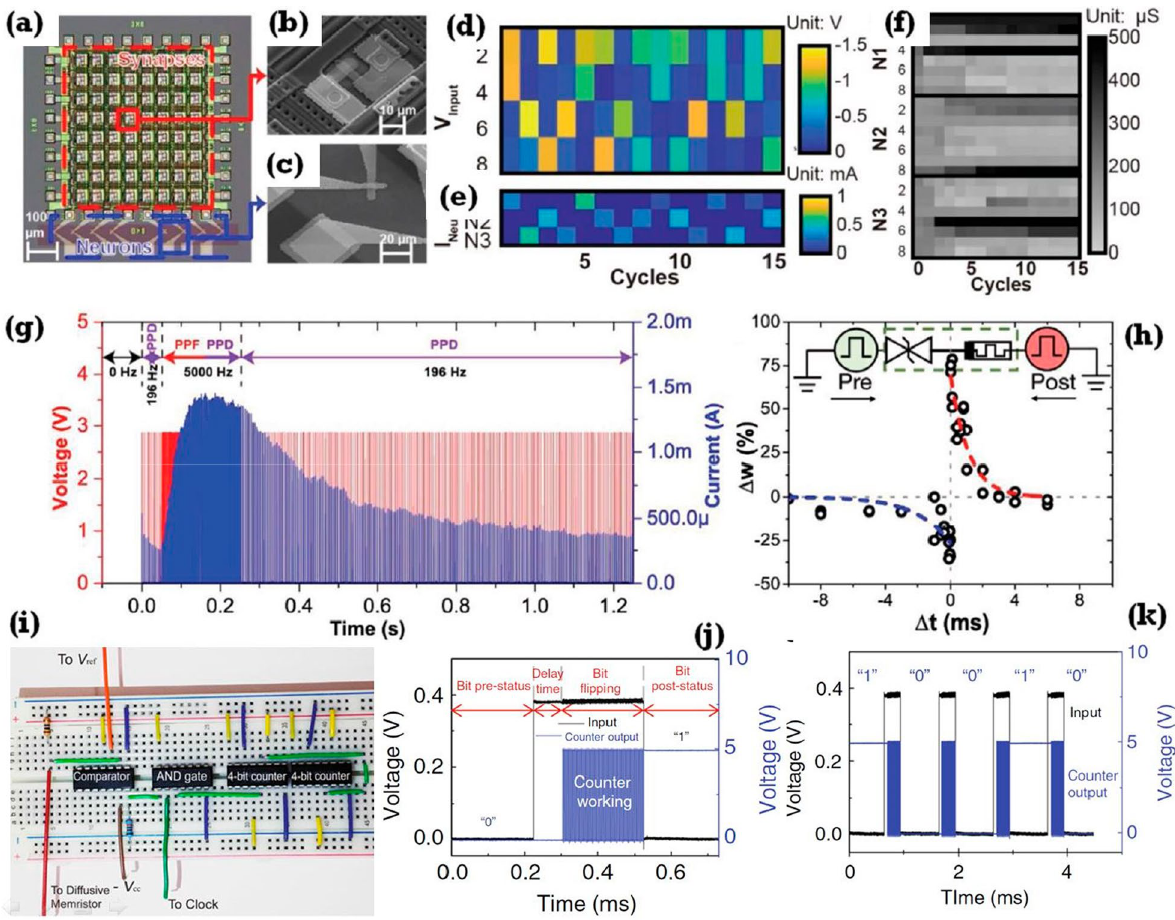
Fig. 29 a Optical image of 8 × 8 RRAM-based neural network in 1T1R configuration. Scanning electron microscope image of b 1T1R cell and c a single 1R cell. d The input pattern, e peak neural current and f synaptic weight at each training cycle. g Experimental observation of short-term synaptic plasticity. h Conductance (weight) change of the drift memristor synapse in series with a diffusive memristor, as a function of the interval between pre and postsynaptic spikes, showing biorealistic STDP. Reproduced with permission from [352]. Copyright 2019 John Wiley and Sons Publishing. i Circuit arrangement of a RRAM device for TRNG application on bread board. j One counter output in response to 1 kHz input voltage pulse. k Random binary out flipping states over continuous switching cycles in the TRNG devices.